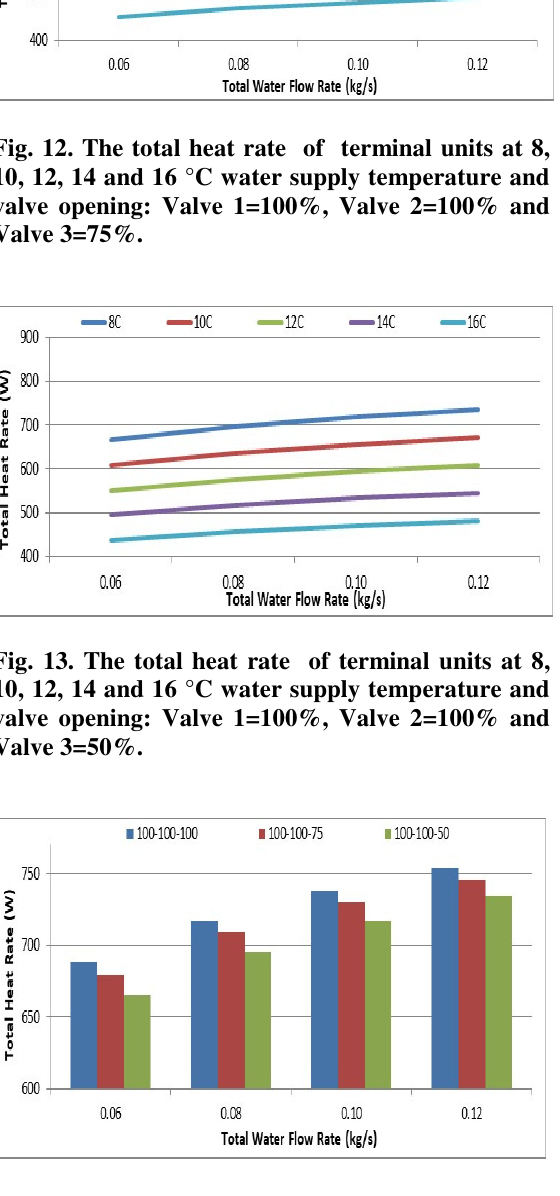
Fig. 14. The total heat rate of terminal units at 8°C water supply temperature and valve opening: Valve 1=100%, Valve 2=100 % and Valve 3=100-75-50%.